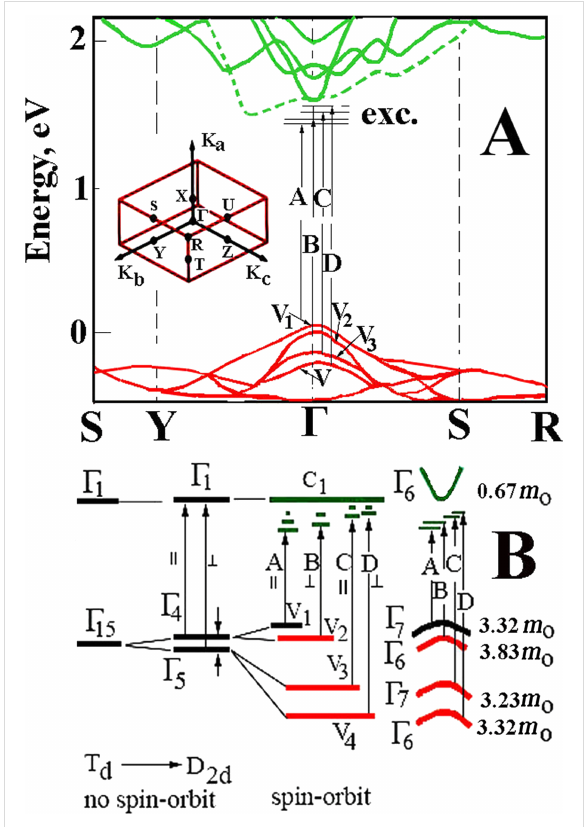
Figure 7: (A) The energy band structure of the Sb 2 S е 3 crystals. Insert illustrates the Brillouin zone. (B) Transformation from the tetrahedral to orthorhombic symmetry due to the spin–orbit interaction and the crystal field in the center of the Brillouin zone. Figure 7B adapted with permission from [24], copyright 2020